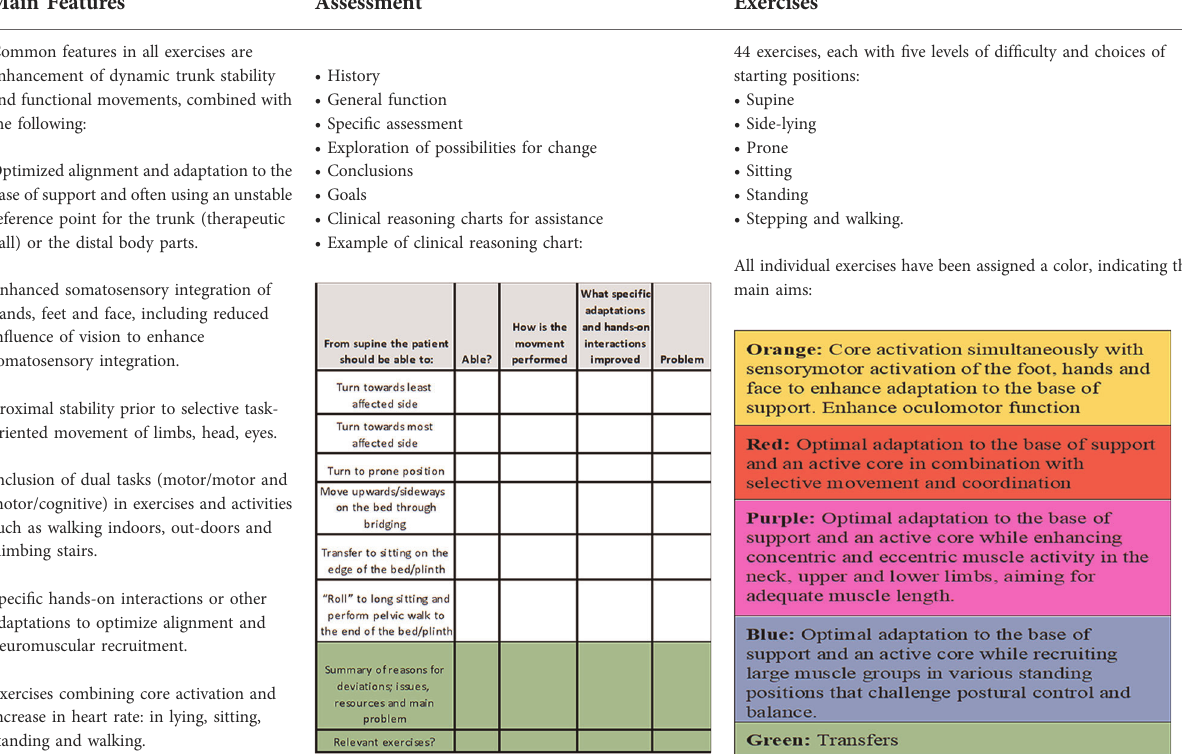
TABLE 1 Outline of the I-core DIST